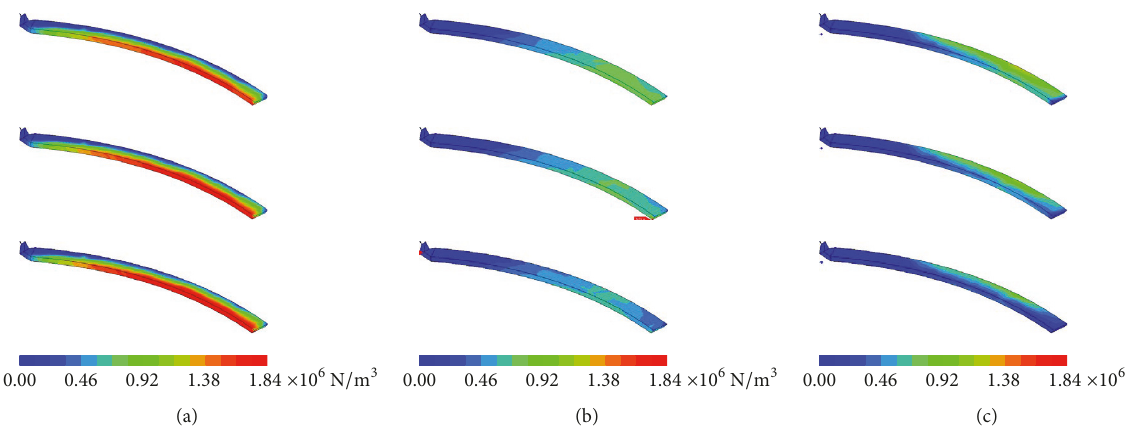
= 221 mm (bottom), 𝑙 = 321mm (middle), and sc sc